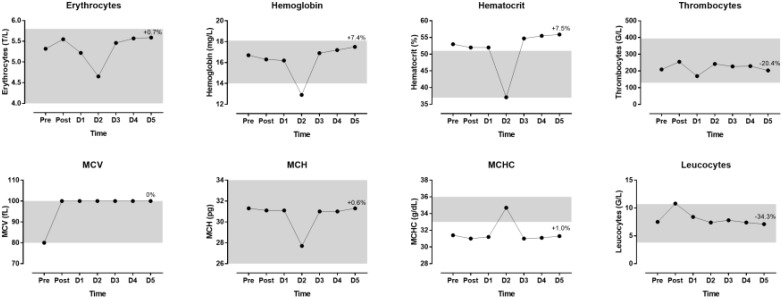
Blood physiology indices during the race and recovery. The shadowed area represents normal reference values. The percentage value over D5 point denotes change from post-race value. D, day post-race.